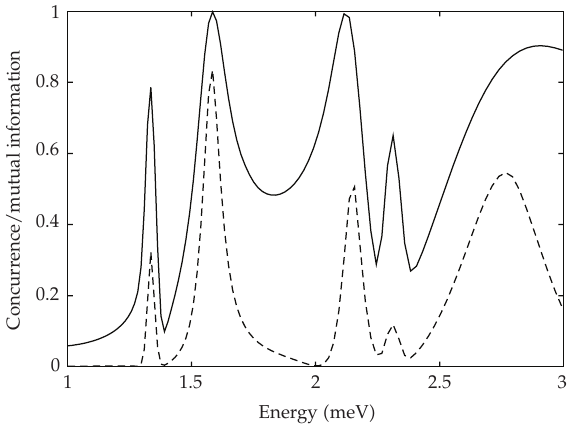
Figure 9: A comparison of the concurrence of the system (cid:9) solid line (cid:10) and the classical mutual information (cid:9) dashed line (cid:10) between the initial state of the qubit and the final position of the electron in the quantum wire over a range of initial ballistic electron energies and with optimized barrier